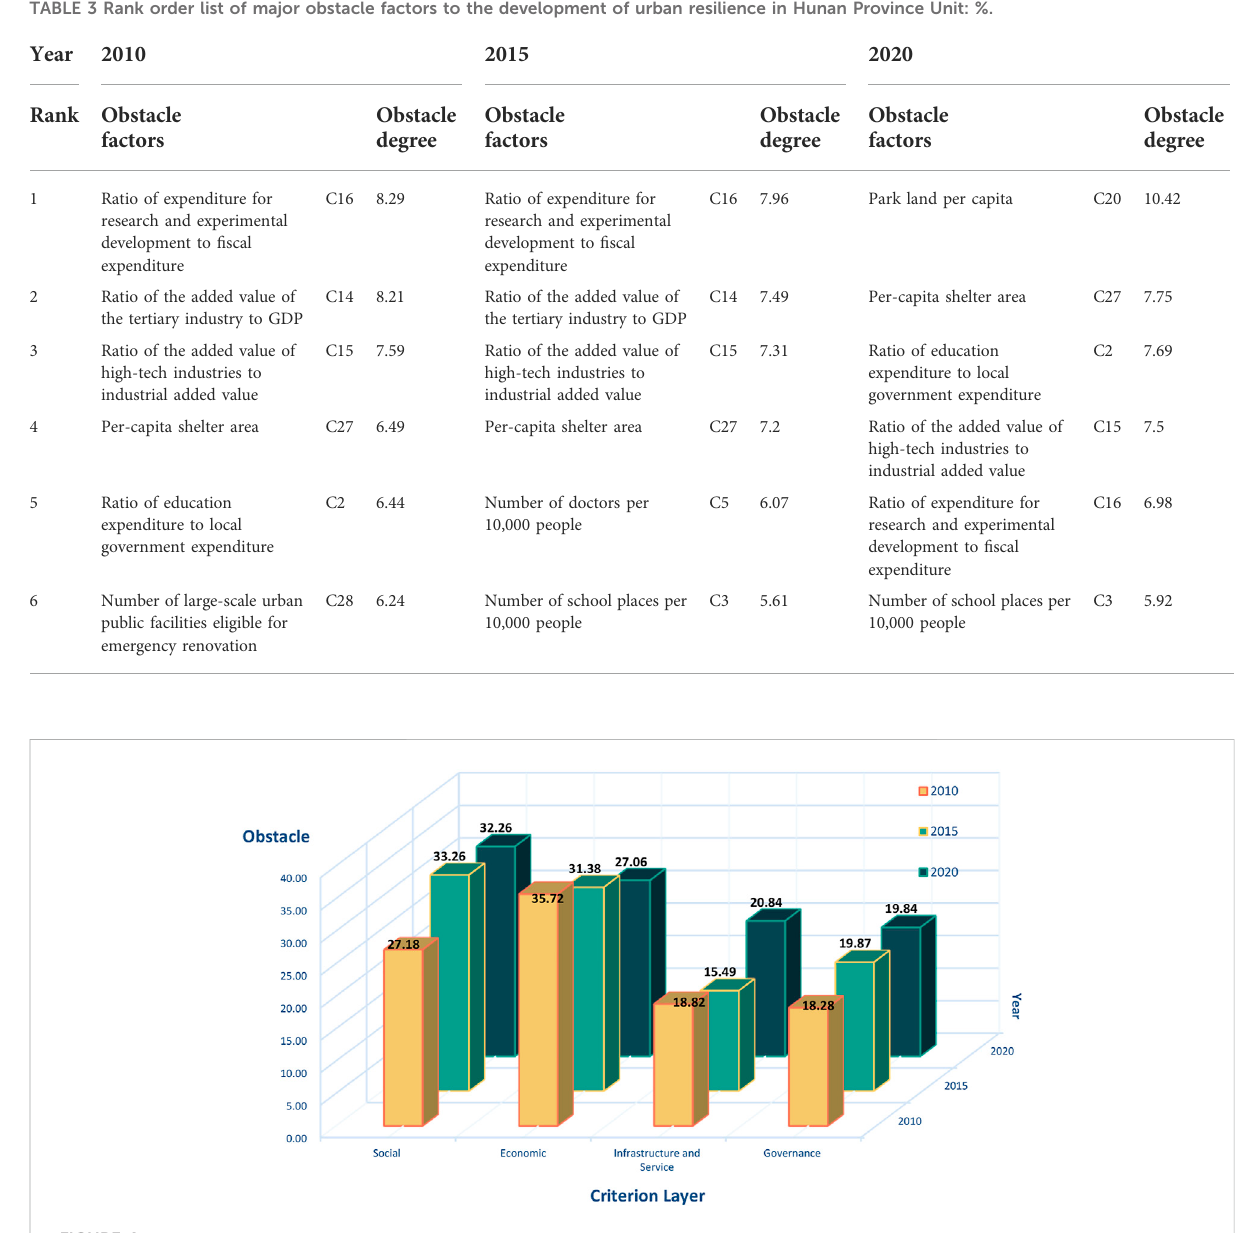
FIGURE 4 Obstacle on criterion layer level of Hunan